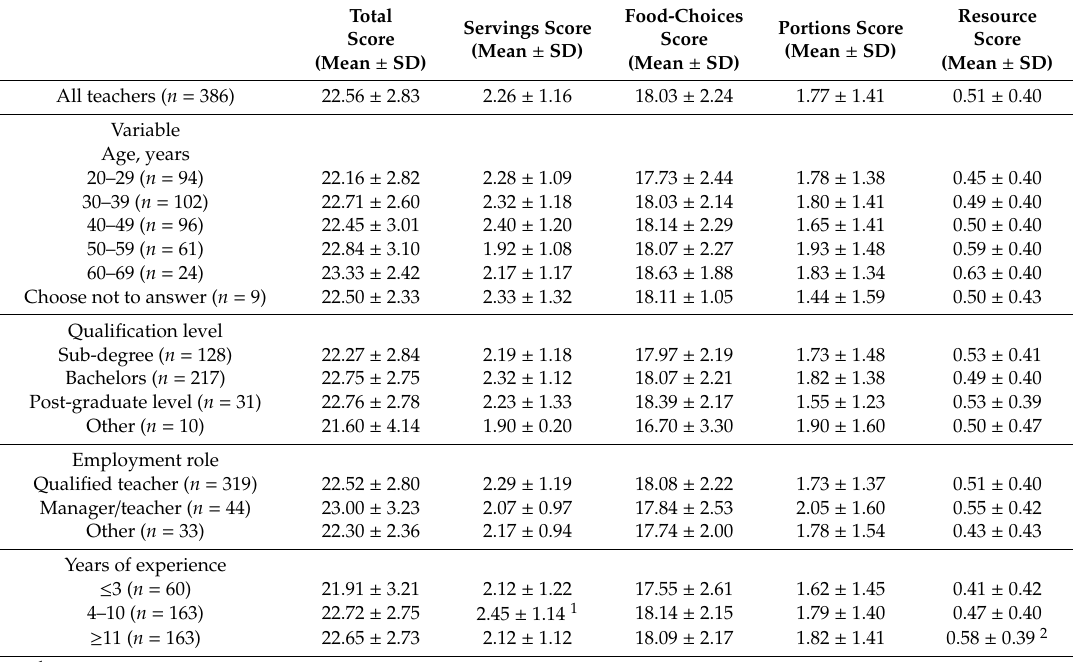
Table 2. Nutrition knowledge scores by participant variables.